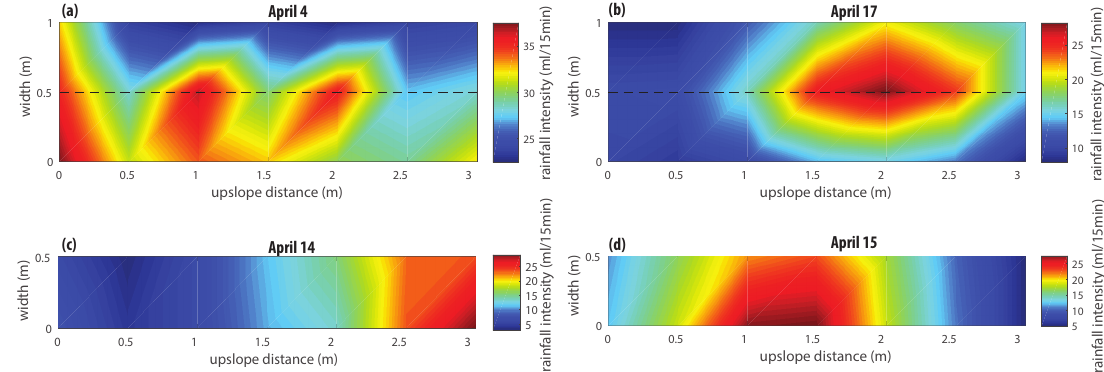
Figure 8. Spatial distributions of the rainfall intensity during four rainfall events. ( a ) 4 April where both hillslopes were sprinkled at the same time; ( b ) 17 April where again both hillslopes were sprinkled at the same time; ( c ) 14 April where only hillslope 2 (including macropores) was sprinkled and ( d ) 15 April where only hillslope 1 (without macropores) was sprinkled. Note that, on 4 April, the amount of rainfall for both hillslopes extremely vary, while, on 17 April, both hillslopes receive approximately the same amount of rainfall, but the intensity